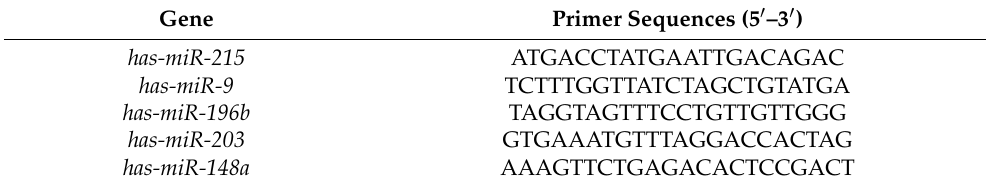
Table 2. Human and mouse sequences and accession numbers for miRNA primers used in RT-PCR.